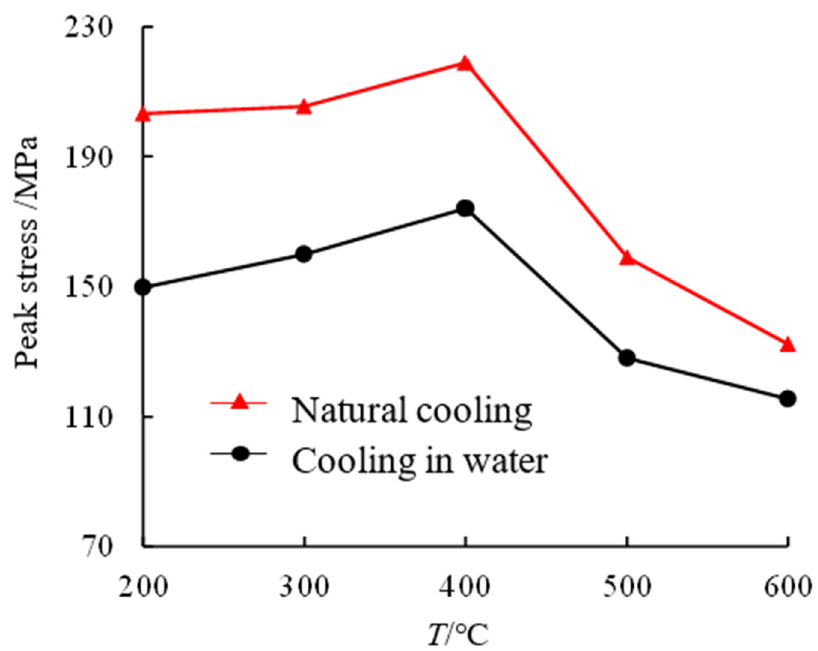
Figure 8. Change of peak strength of sample after different cooling methods.